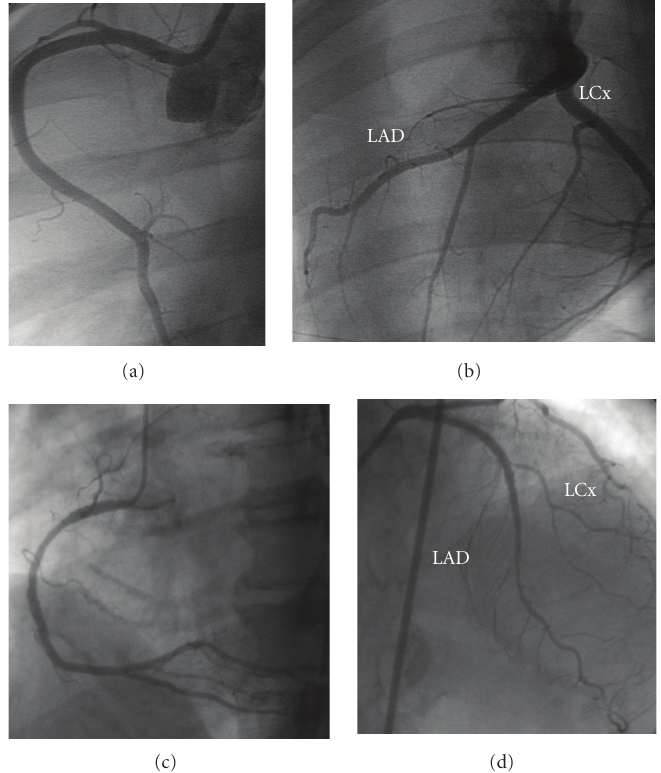
Figure 1: Porcine (a and b). (a) Right coronary artery. (b) Left coronary system. Human (c and d). (c) Right coronary artery. (d) Left coronary system. Similar anatomy and coronary distribution is shown of the left anterior descending, left circumflex, and right coronary